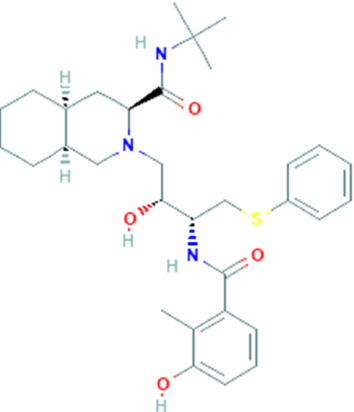
Figure 3. Chemical structure of